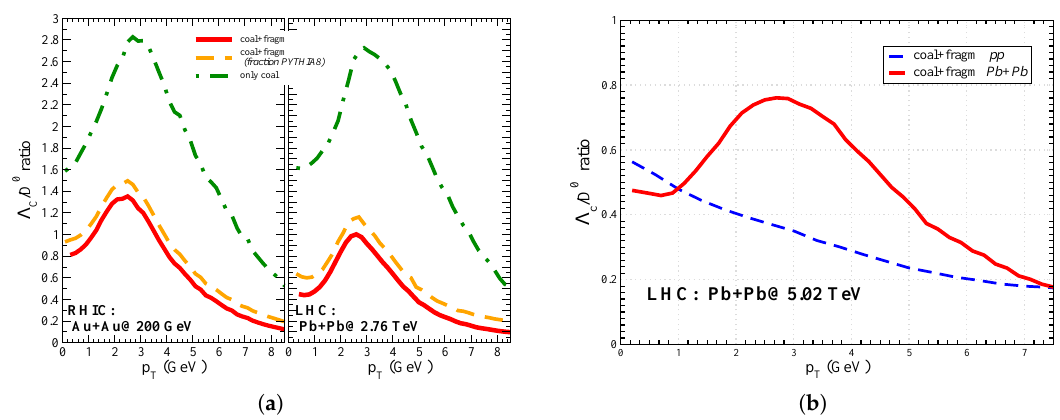
Figure 2. (Color online) ( a ) (left) Λ + c to D 0 ratio as a function of p T and at mid-rapidity for Au + Au √ s = 200GeV (left panel) and for Pb + Pb collisions at collisions at ( b ) (right) Λ + c to D 0 ratio as a function of p T and at mid-rapidity for Pb + Pb collisions at